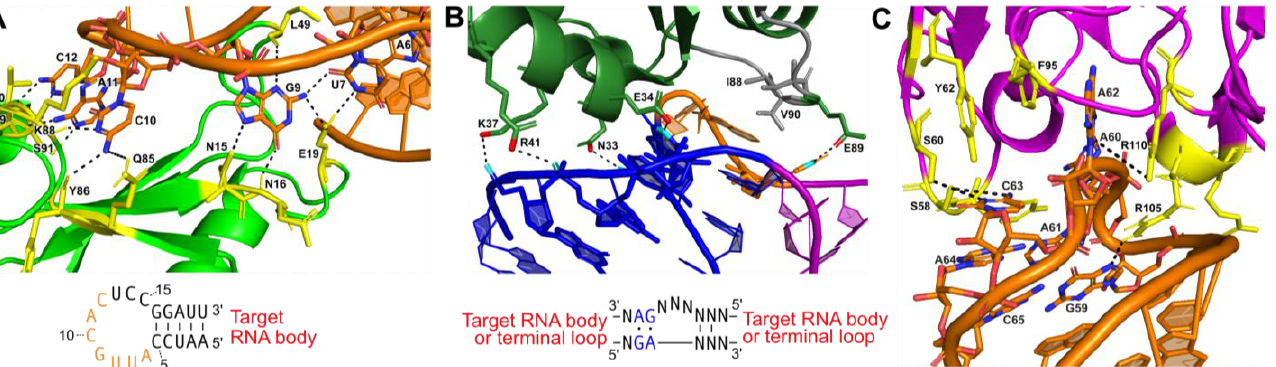
Figure 3. Protein-assisted crystallization modules: ( A ) Interaction between U1A (green) and a 21- nucleotide (nt) hairpin (orange) (PDB:1URN). Several residues form hydrogen bonds (black dashes) with 7 nucleotides of the 12 nt stem-loop U1A binding site in the RNA hairpin. The interaction is further stabilized by base stacking between adjacent nucleotides in the stem-loop. Participating amino acid residues are colored yellow. The hairpin sequence for engineering is also shown with interacting nucleotides (orange). ( B ) Interaction between ribosomal protein L7Ae and a kink-turn (PDB:4BW0). The NC helix (blue) and C helix (magenta) are shown. The bulge (orange) forms hydrophobic interactions with several residues in L7Ae (green; hydrophobic interacting gray). The consensus sequence for engineering is also shown. ( C ) Interaction between the Fab BL3 antibody (purple) and the GAAACAC stem-loop binding site (orange) in an in vitro evolved RNA ligase (PDB:3IVK). Several base stacking interactions and hydrogen bonds (black dashes) form between nucleotides of the stem-loop and amino acids from the Fab. Base stacking between nucleotides of the stem-loop also occurs. Participating amino acid residues are colored yellow. No engineering sequence is shown, as antibody–RNA interactions are unique for each target obtained from the phage display